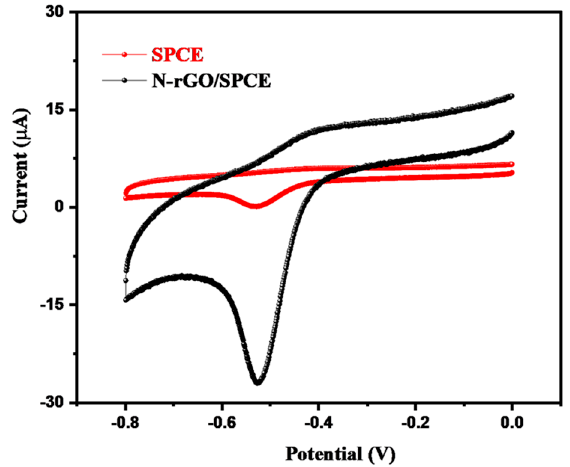
Figure 7. The CV curves of SPCE (red) and N-rGO/SPCE (black) in the presence of 0.01 mM H 2 O 2 in 0.1 M PBS of pH 7.0 at a scan rate of 50 mVs − 1 .